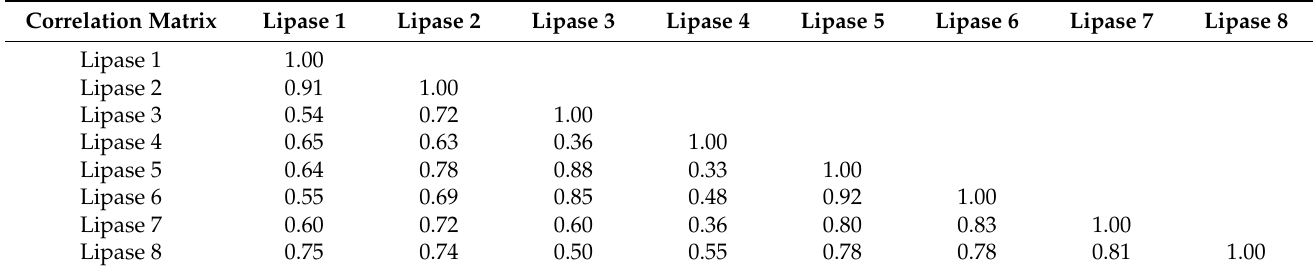
Table 7. Correlation matrix of structurally conserved regions-SASA.